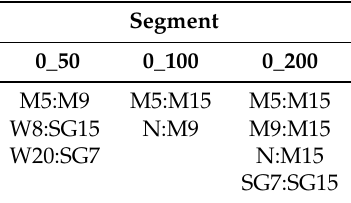
Table 2. Time series, between which significant differences in the LLE values were not confirmed—the first main period (0–200